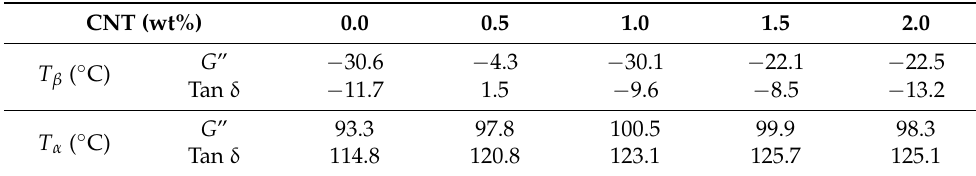
Table 2. Transition temperatures of neat POM and POM/CNT nanocomposites as a function of CNT concentration, based on DMA data. CNT (wt%) 0.0